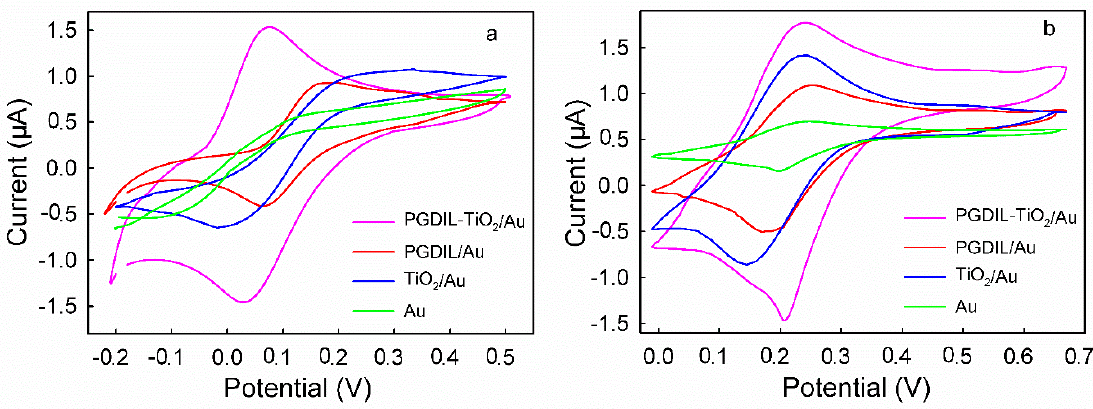
Figure 5. The CV results of ( a ) 0.1 mmol/L HQ and ( b ) 0.05 mmol/L CC at different modified electrodes. The scan rate was 0.1 V/s.